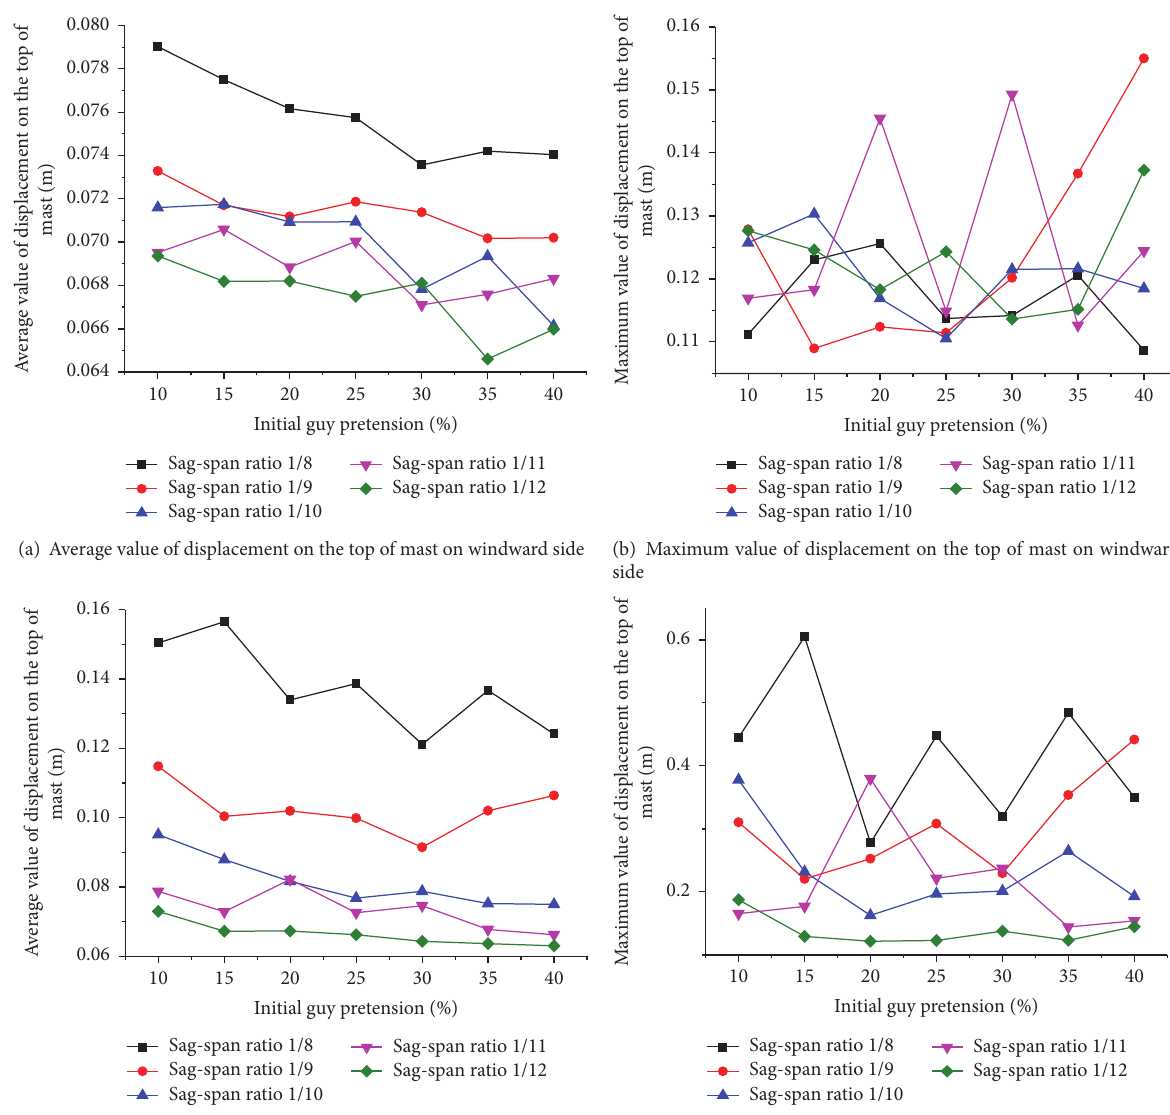
Figure 8: Effect of initial guy pretension and sag-span ratio on